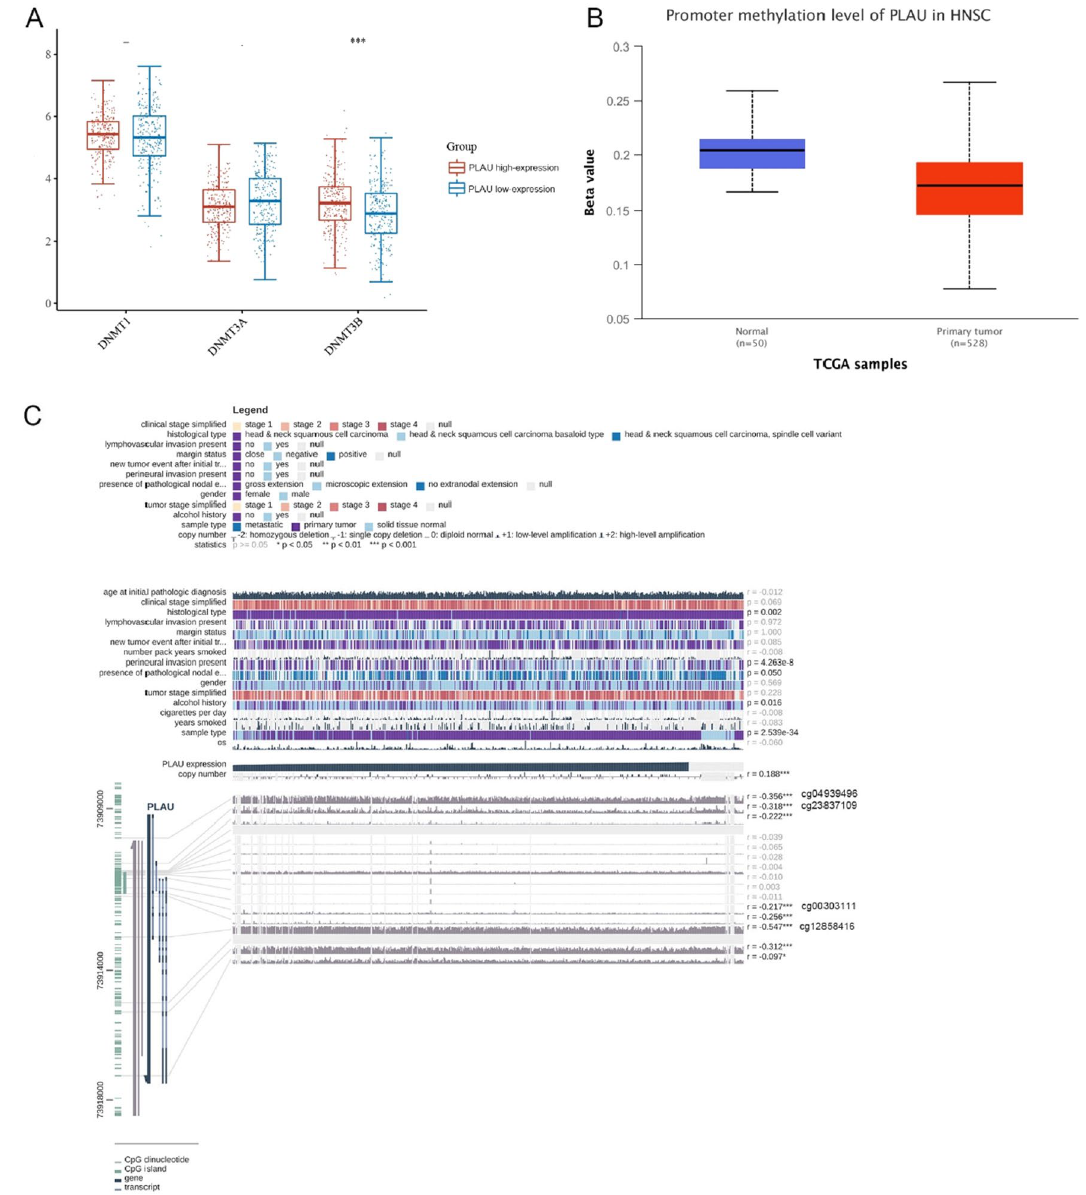
Figure 8. ( A ) Differential expression of three DNA methyltransferases (DNMT1, DNMT3A, and DNMT3B). ( B ) Methylation was evaluated using UALCAN. ( C ) The methylation site of PLAU DNA sequence